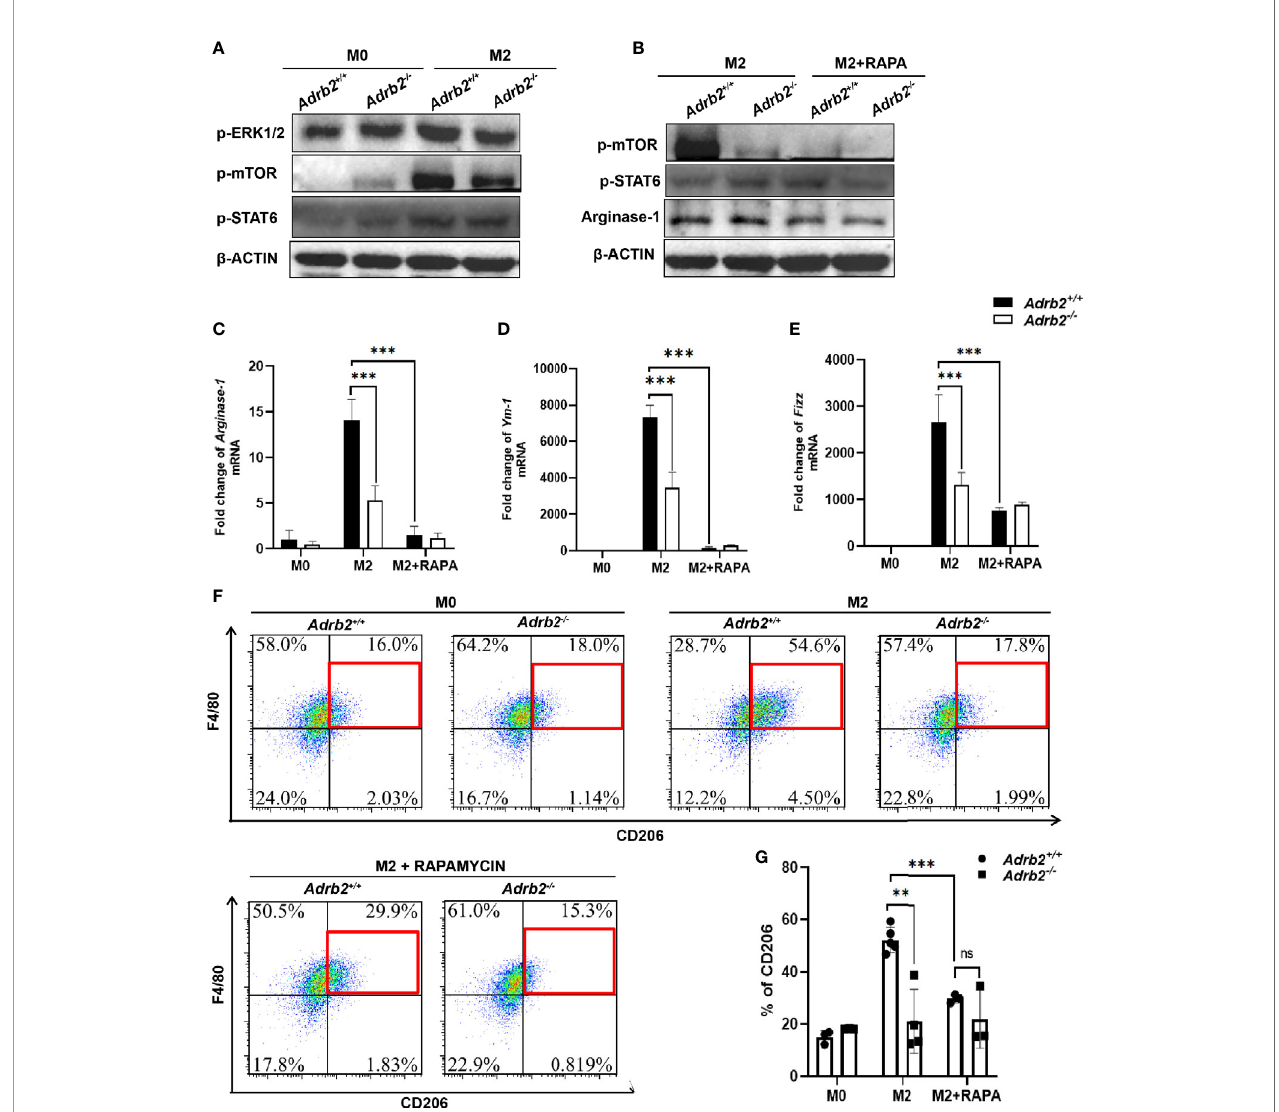
FIGURE 6 | b 2-AR controls the type 2 in fl ammatory response in vitro in ERK/mTORC1 signaling. The experimental setup of the in vitro model used bone marrow – derived macrophages (BMDM). BMDM was divided into three groups: M0 (unstimulated macrophages), M2 or alternatively activated macrophages (IL-4-stimulated macrophages for 24 h), and M2 + Rapamycin (100 ng/ml for 24 h). (A) The increase in M2 markers in M2 Adrb2 +/ + macrophages is associated with an increase in the phosphorylation of ERK1/2 and mTORC1. (B) The inhibition of mTOR by Rapamycin signi fi cantly decreases the phosphorylation of mTOR, resulting in the decrease of Arginase-1. (C – E) The inhibition of mTORC1 signi fi cantly decreases the mRNA level of M2 markers such as Arginase-1 (C) , Ym-1 (D) , and Fizz (E) in M2 Adrb2 +/ + macrophages. (F, G) The inhibition of mTORC1 also decreases the percentage of CD206 in M2 Adrb2 +/ + macrophages. Compared with indicated groups, ** P < 0.01, *** P < 0.001; ns, not signi fi